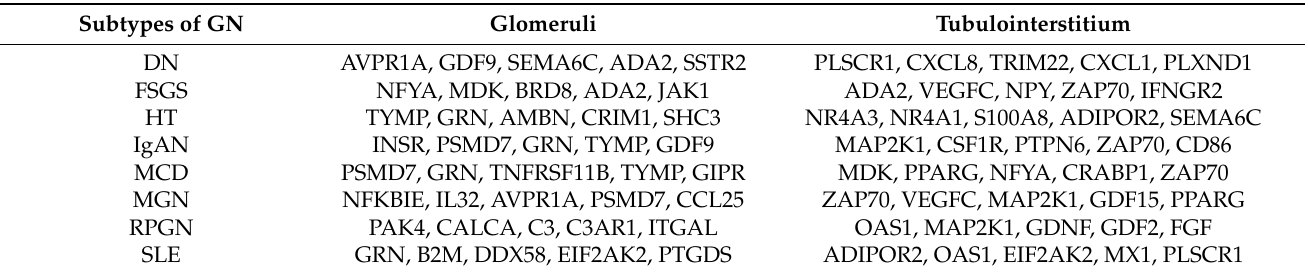
Table 3. The top five characteristic genes of eight GN